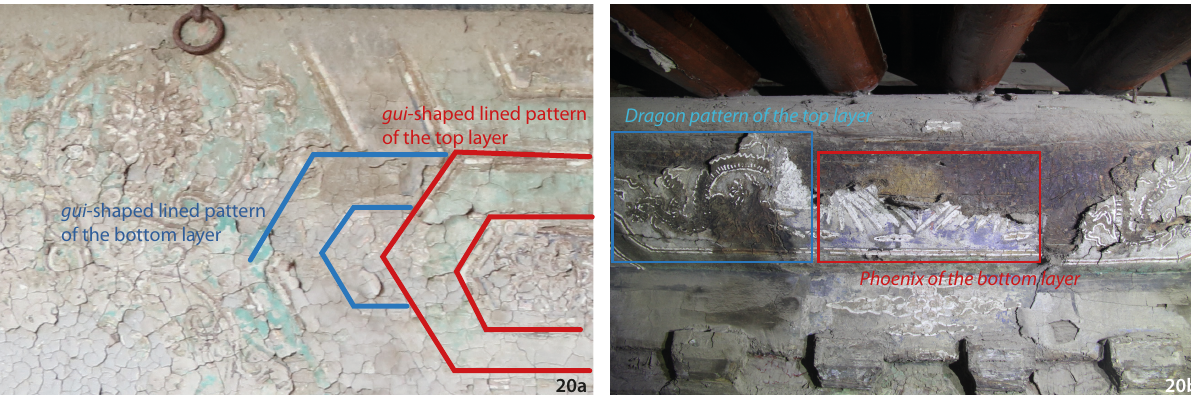
Figure 20a Decorative polychrome painting on an architrave at the west façade of the gong -shaped gallery (Source: Hong Yang). Figure 20b Two layers of decorative polychrome painting at the middle portion of the third intermediate purlin at the south of the western surrounding building (Source: Hong